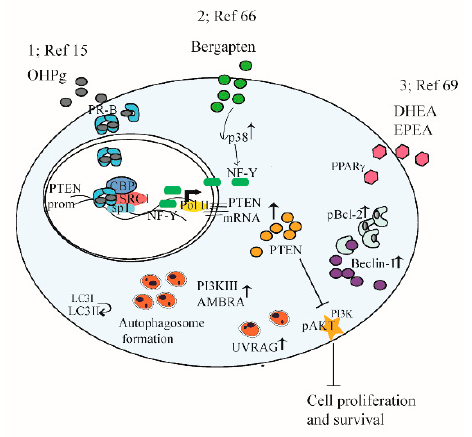
Figure 2. A schematic summary illustrating mechanisms targeting PTEN and autophagy in cancer cells. See the text for details. (1) The functional interplay between progesterone receptor-B and PTEN , via AKT, modulates autophagy in breast cancer cells. (2) PTEN as a key target of Berga PTEN action in breast cancer cells for the induction of autophagy. (3) DHEA and EPEA through PPAR γ -increased expression PTEN , resulting in the inhibition of AKT–mTOR pathways, induction of Bcl-2 phosphorylation, its dissociation from Beclin-1, and autophagy